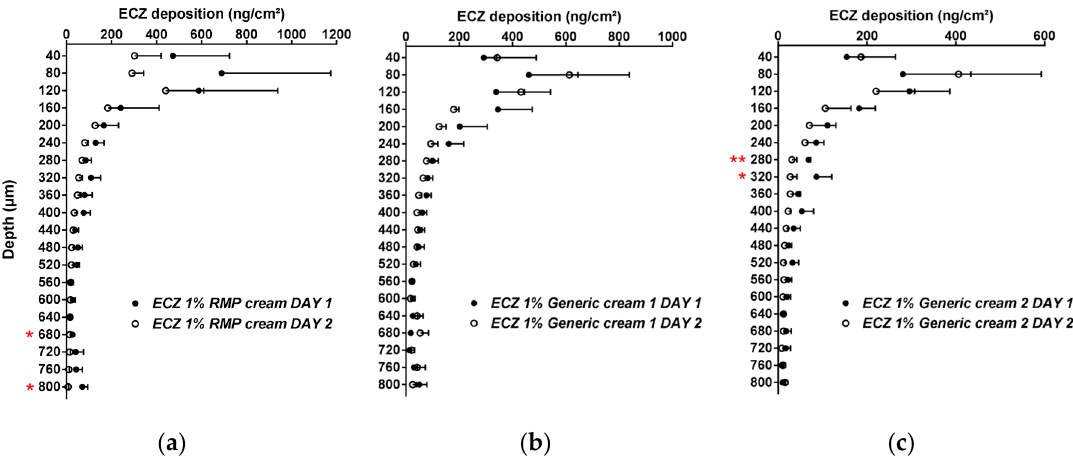
Figure 1. Inter-day reproducibility of the cutaneous biodistribution profile of ECZ in porcine skin lamellae (2 × 20 µm + 19 × 40 µm) to 800 µm (full-depth) for the three formulations: ( a ) reference medical product (ECZ 1% reference medicinal product (RMP) cream), ( b ) ECZ 1% Generic cream 1 and ( c ) ECZ 1% Generic cream 2. Tested groups: Day 1 ( (cid:8) ) and Day 2 ( ). (Mean ± CI 90% ; n = 6). p -values were calculated using a Student’s t test; statistically significant di ff erences are denoted by asterisks (* p < 0.05; ** p < 0.005).